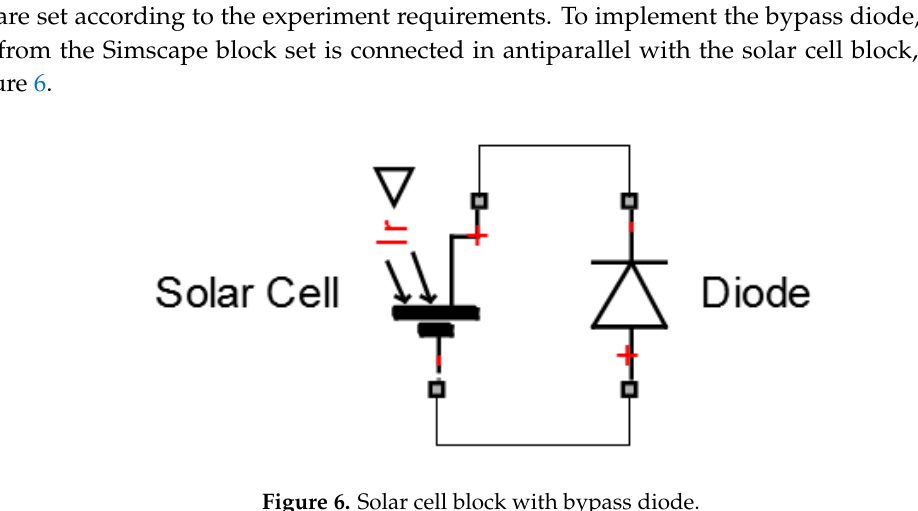
Figure 6. Solar cell block with bypass diode.